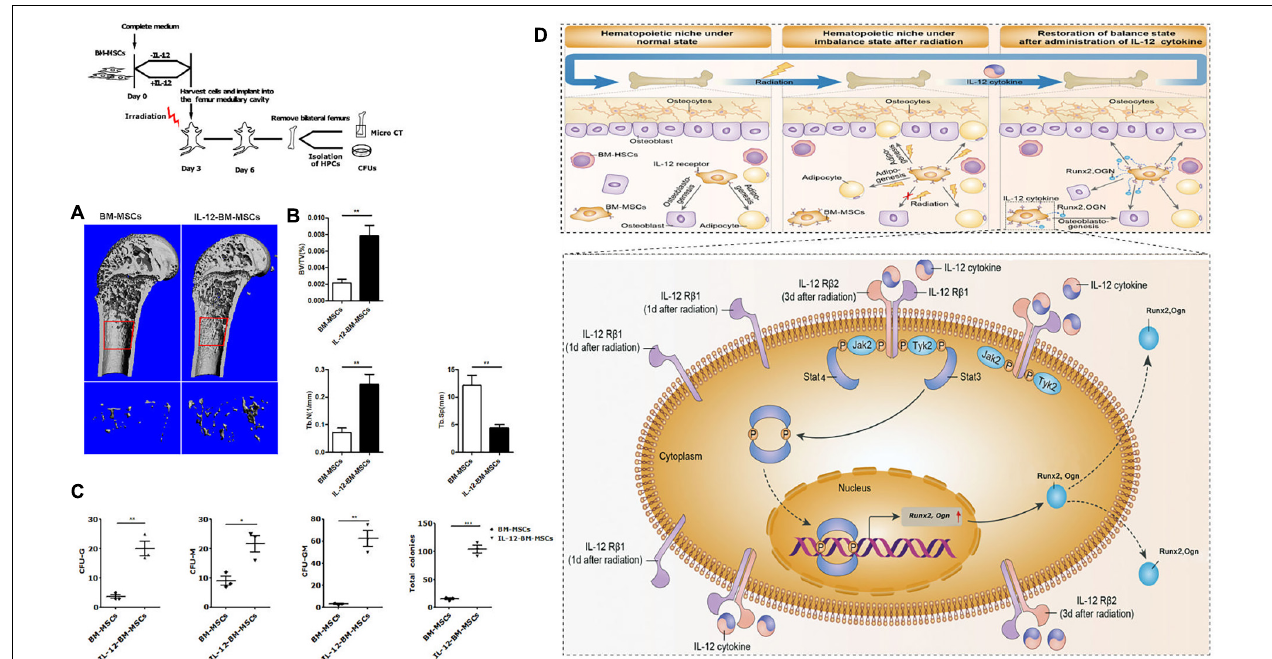
FIGURE 6 | The haematopoiesis supports bone formations of BM-MSCs co-cultured with 0.2 ng/ml IL-12 for 24 h and proposed a mechanism of IL-12-induced osteogenesis in BM-MSCs after irradiation. (A,B) Bone mineral density analysis of bilateral femur of 5 Gy irradiated mice which were cells transplanted at the bilateral femur by using Scanco Medical CT-40 instruments. All the data were presented as the mean ± SEM, n = 5. (C) HSPCs colonies analysis bilateral femur of 5 Gy irradiated mice which were cells transplanted at the bilateral femurs. (D) Firstly, irradiation-induced the upregulation of IL-12 receptors, especially IL- 12R β 1. Then the TYK2/STAT3 signaling activation, such as Tyk2 activation, STAT3 phosphorylation, nuclear translocation after dimerization, were triggered. In succession, the expression initial of osteogenic genes, Runx2 and Ogn, increased, promoting the osteoblast differentiation of BM-MSCs. ↑ , increase. The results were considered significant at * P < 0.05, ** P < 0.01, and *** P <